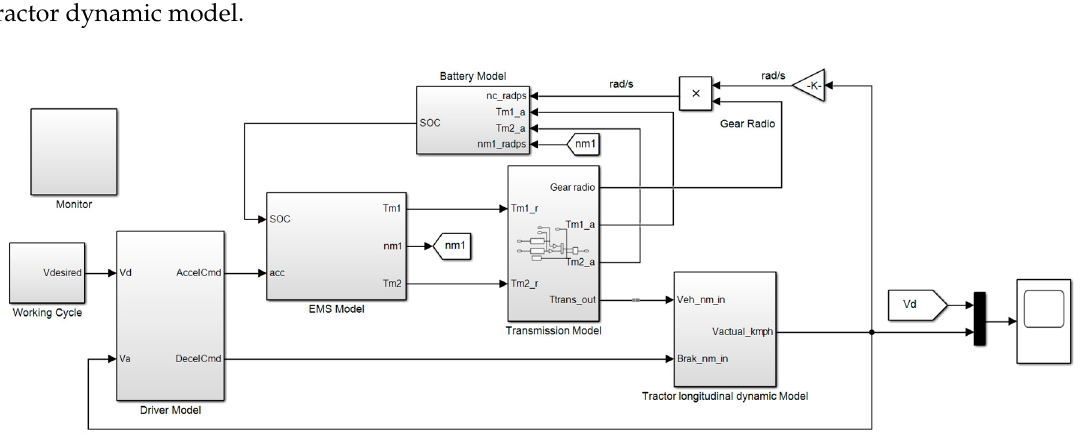
Figure 6. Simulation model for a DMET equipped with the DMCPS.